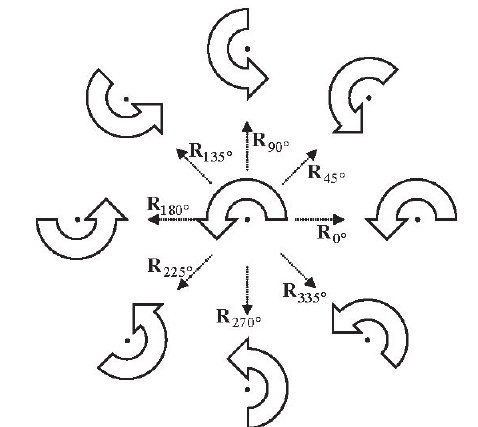
Figure 7 Some rotational magnifications. Note that the anti - clockwise sense of the arrow in the object is preserved in the images. IR = and IR −= ° 0 ° 180